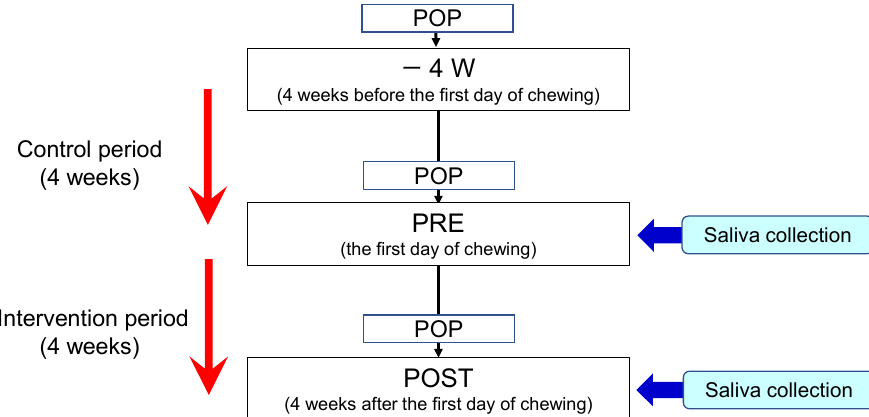
Figure 5. Experimental protocol. POP indicates professional oral prophylaxis.